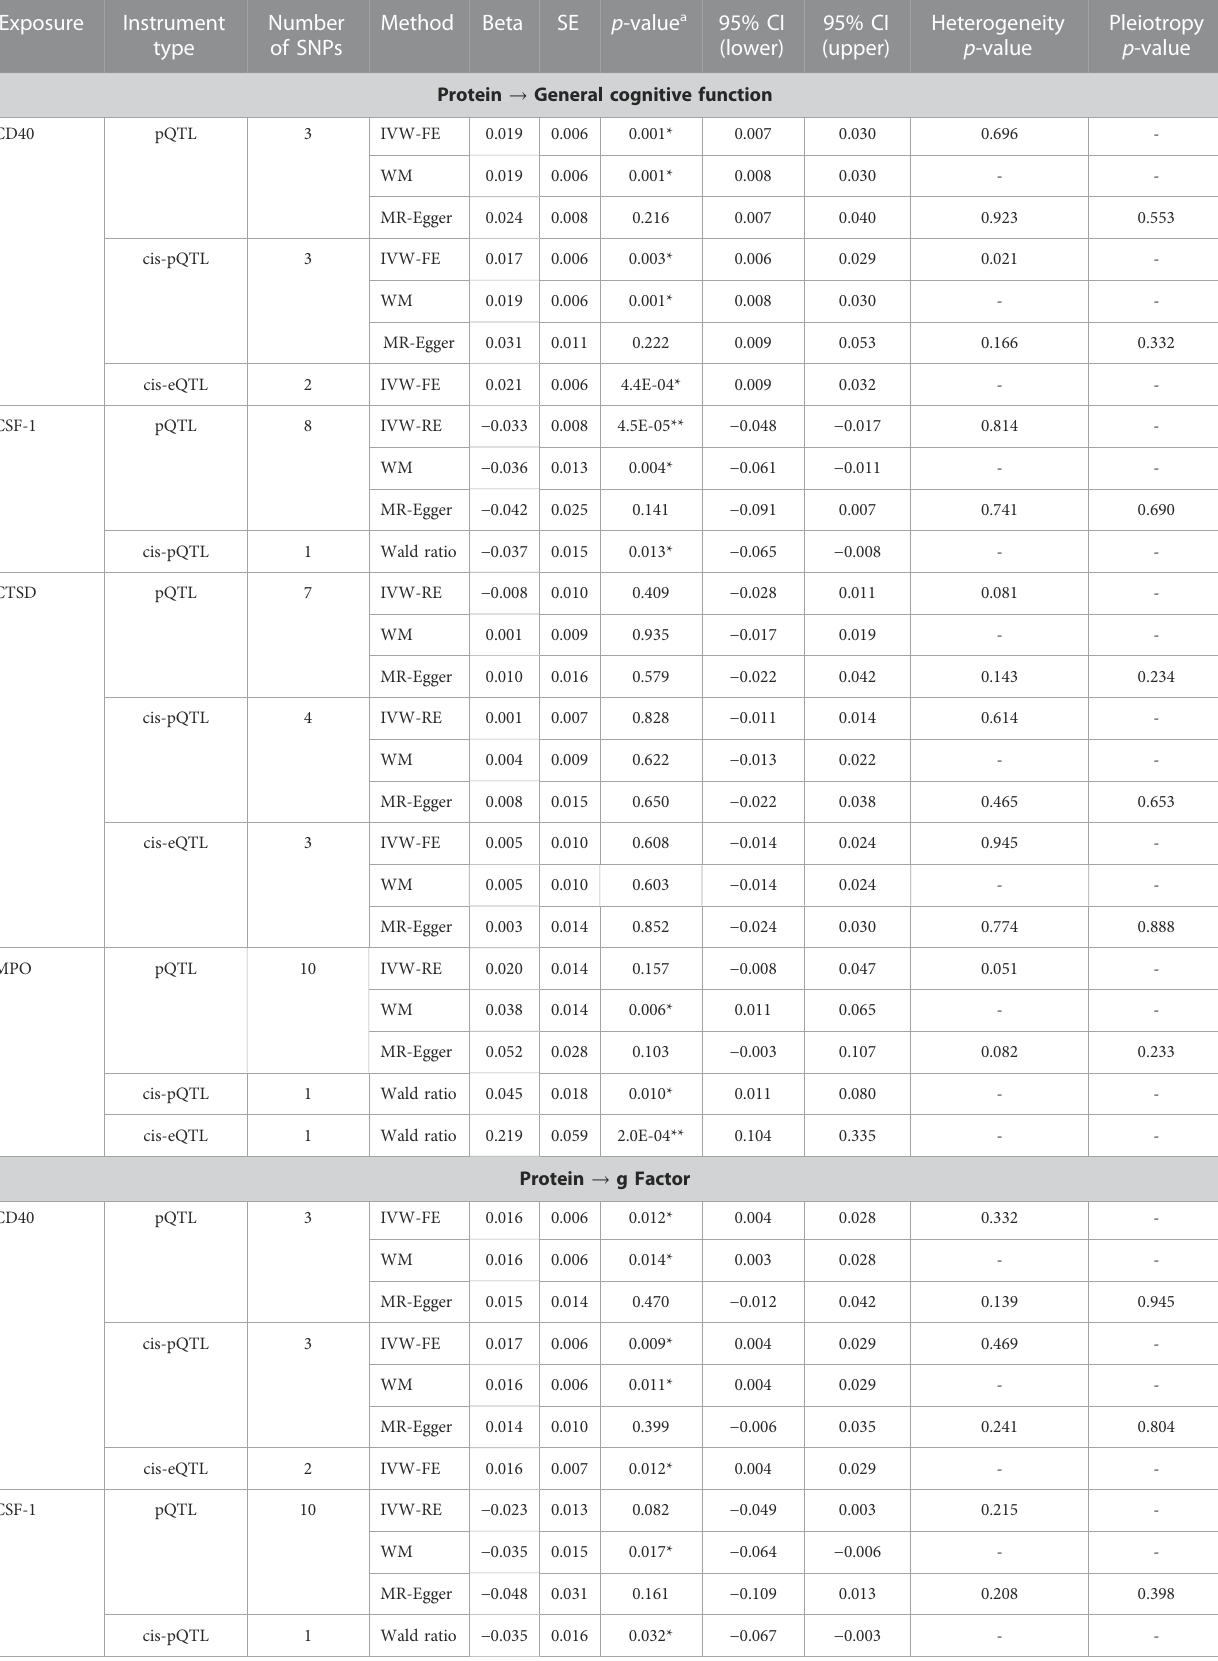
TABLE 1 Associations of circulating proteins with cognitive performance based on Mendelian randomisation